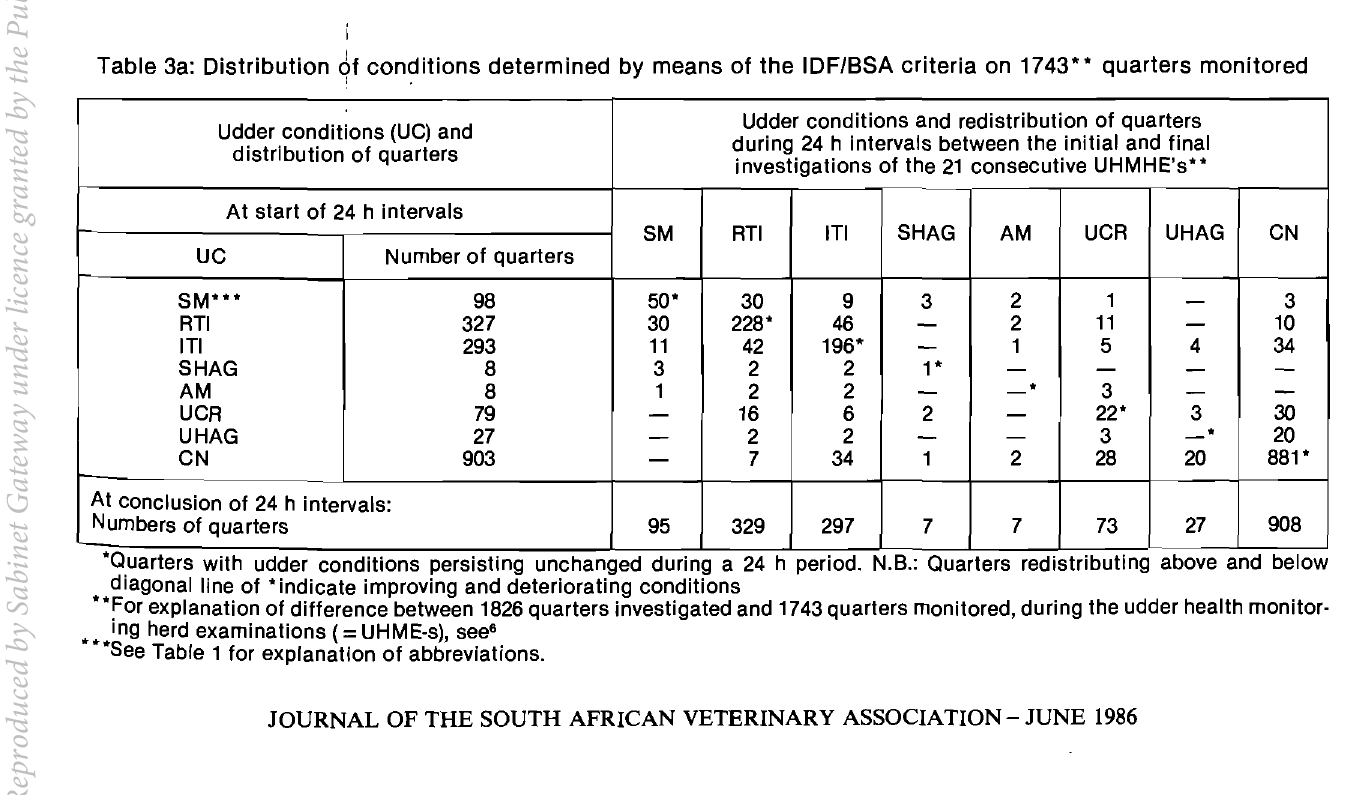
Table 3a: Distribution 6f conditions determined by means of the IDF/BSA criteria on 1743* * quarters monitored